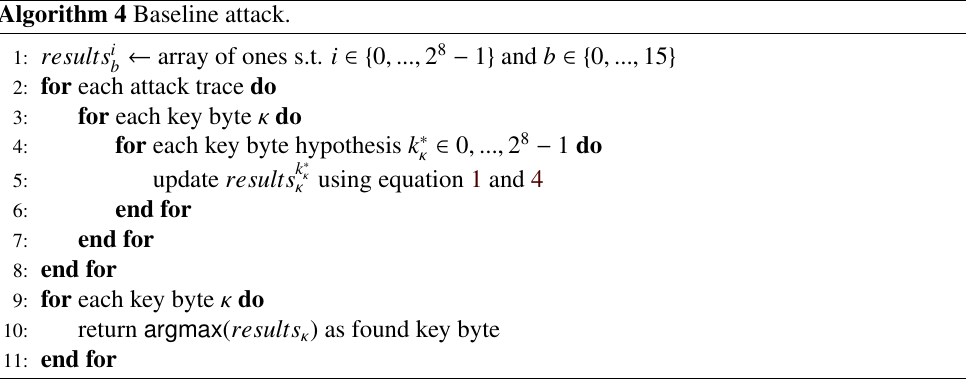
Algorithm 4 Baseline